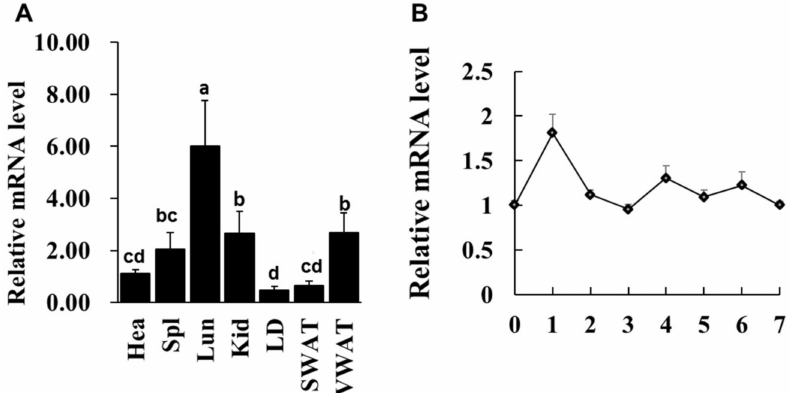
Figure 1. The LXR α gene expression pattern in various tissues and during intramuscular preadipocyte differentiation. ( A ) The LXR α mRNA level in heart (Hea), spleen (Spl), lung (Lun), longissimus dorsi (LD) muscle, subcutaneous white adipose tissue (SWAT) and visceral WAT (VWAT), n = 6. ( B ) The LXR α mRNA level on Days 0–7 in induced differentiation intramuscular adipocyte ( n = 6). Data are shown as the means ± standard error of the mean (SEM). Different lowercase represents significant difference ( p <